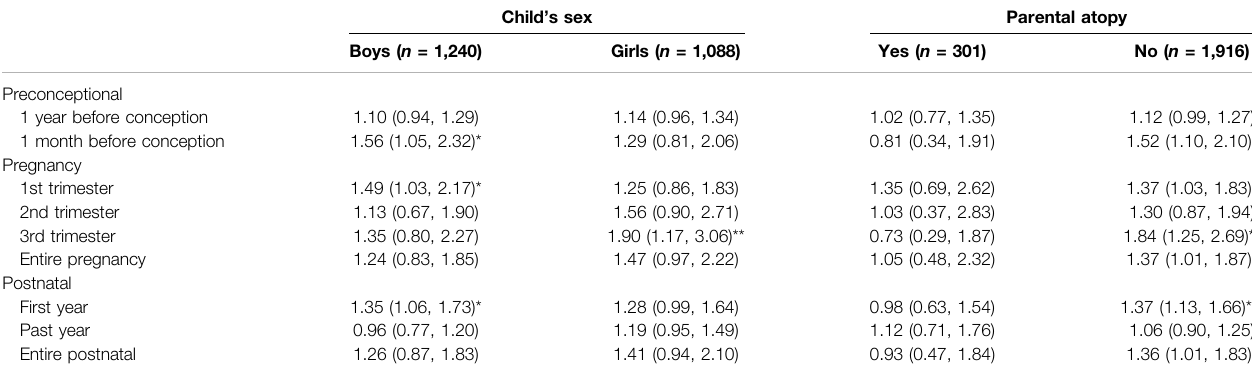
TABLE 5 | Odds ratio of laryngitis due to exposure to outdoor SO 2 exposure during different time windows strati fi ed by personal factors including child ’ s sex and parental atopy ( n =